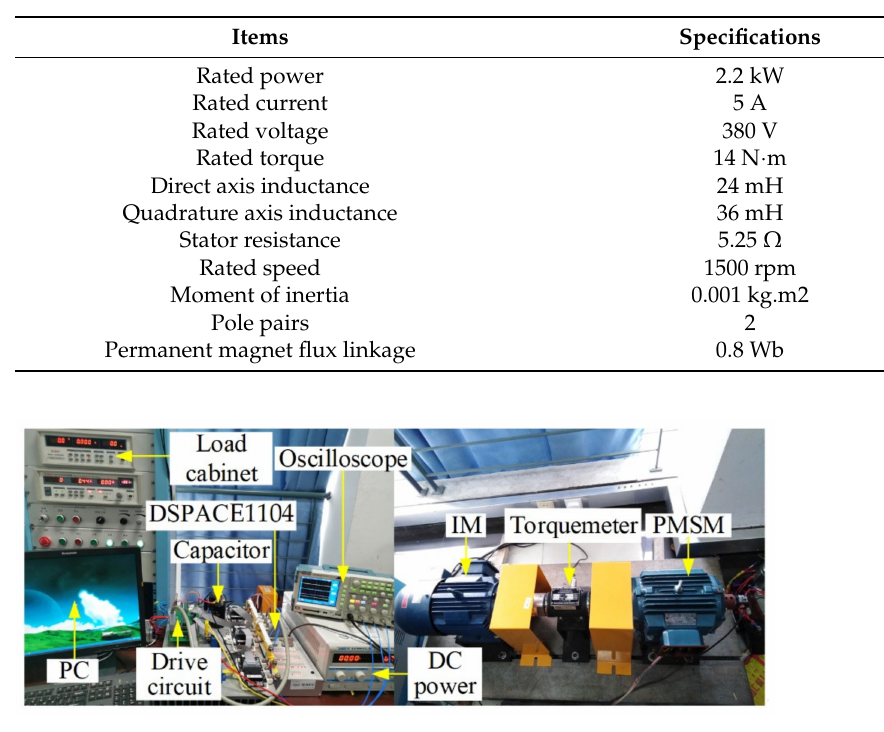
Table 2. Motor parameters.